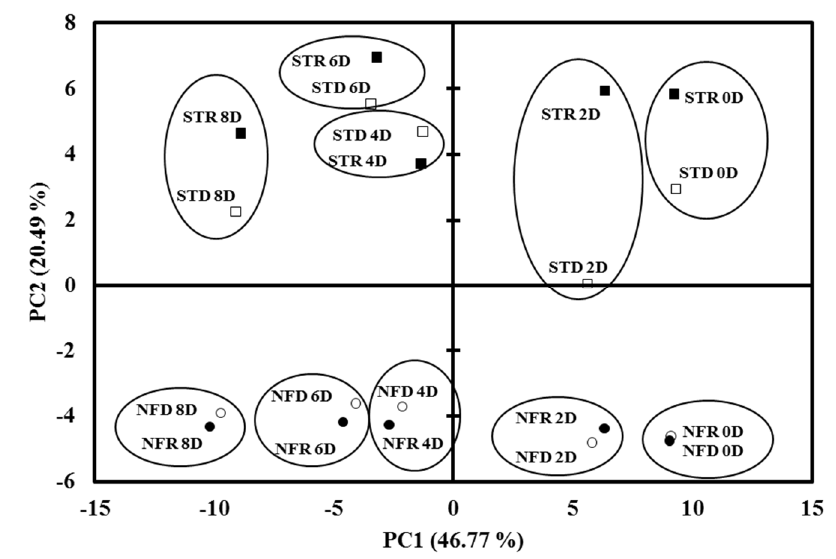
Figure 3. Principal component analysis of the combined metabolites at different ripening stages (0, 2, 4, 6, and 8 days of ripening) in mangoes. STD, dry season ‘Nam Dok Mai Si Thong’ ( ); STR, rainy season ‘Nam Dok Mai Si Thong’ ( ); NFD, dry season ‘Nam Dok Mai No. 4’ ( ); NFR, rainy season ‘Nam Dok Mai No. 4’ ( ).